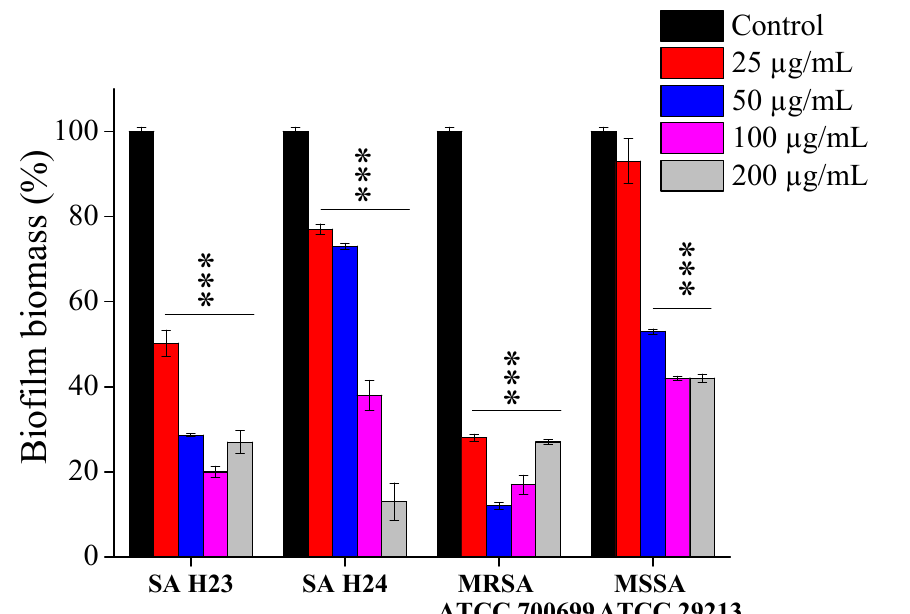
Figure 3. The eradication effect of EEP1 on 24 h-old biofilm biomass of S. aureus SA H23, SA H24 clinical isolates, S. aureus ATCC 29213 (MSSA), and S. aureus ATCC 700699 (MRSA) by crystal violet staining. Asterisks indicate statistically significant differences (one-way ANOVA) between each concentration treatment of EEP1 and untreated biofilms (*** p < 0.001).